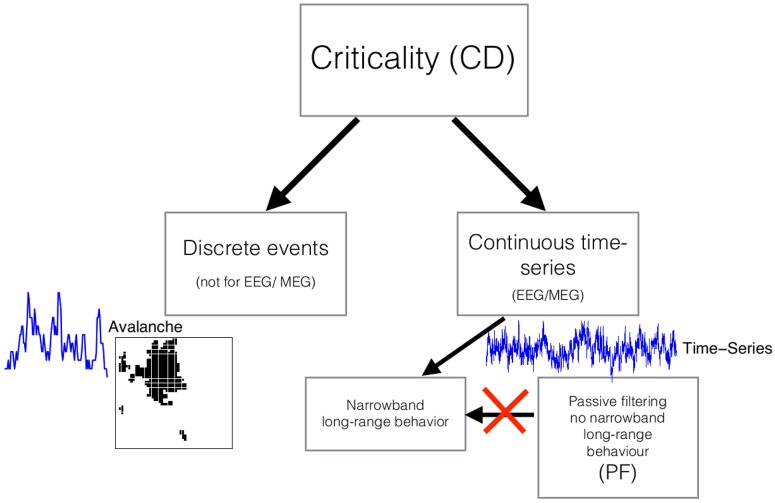
The approach taken in this paper.Criticality implies that the distibutions of discrete avalanches are power-law (left hand side). However analysing discrete dynamics is problematic on the basis of continuous EEG/ MEG recordings. Until now it was unclear how to distinguish criticality from alternative explanations of 1/fγ power-spectra on the basis of continuous data (right hand side) such as EEG/ MEG. We show that criticality implies that the narrowbands of the continuous data have specific long-range properties (left hand branch of right hand side). The passive-filtering theory of the origin of the 1/fγ form of EEG/ MEG power-spectra does not predict such long-range narrowband properties (right hand branch of right hand side). Thus we have a criterion to distinguish criticality from passive filtering on the basis of MEG/ EEG recordings. We perform this test on empirical data.